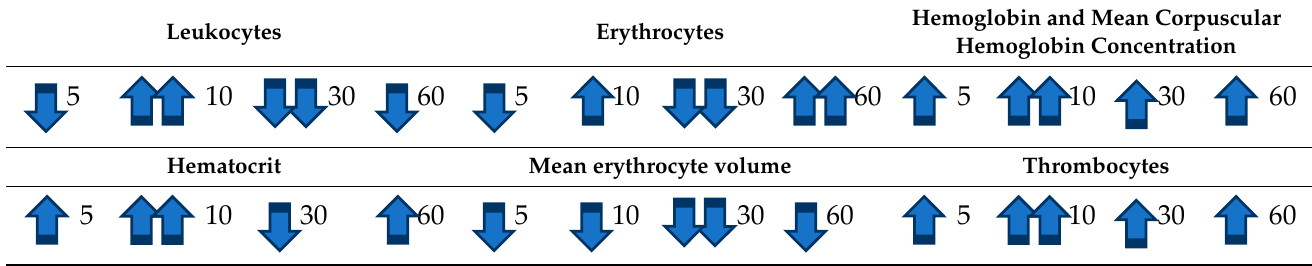
Table 2. Effect of gold nanoparticle size on hematology results in mice incubated with AuNP at a dose of 4000 μ g/kg for 28 days. Numerical values are given in nm ↑↑ —largest increase, ↑ — increase ↓ — decrease.